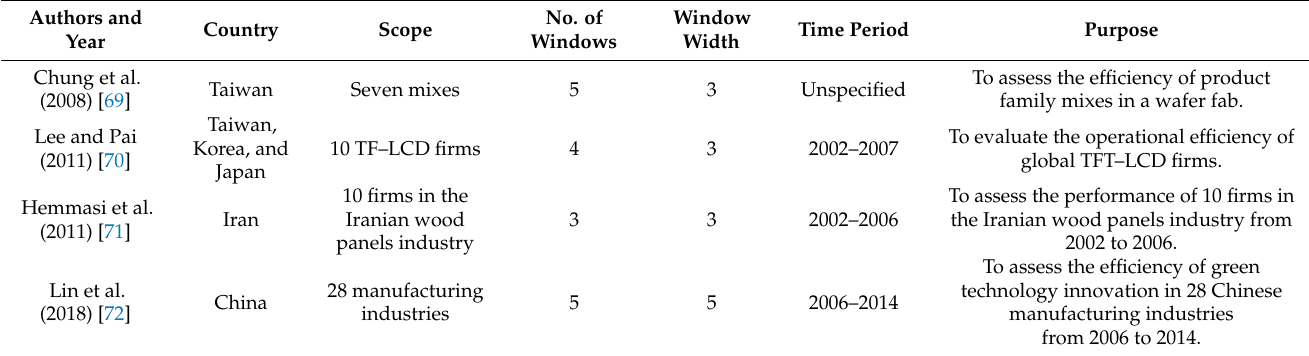
Table 7. Articles classified under the manufacturing